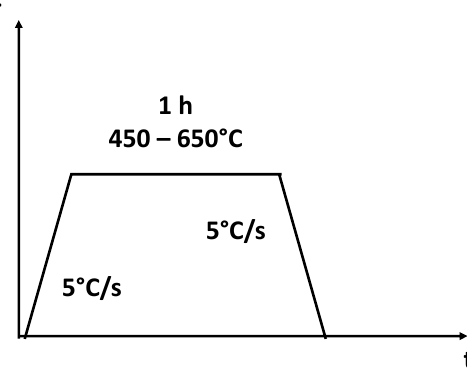
Figure 1. Scheme of the tempering heat treatments applied in this work.